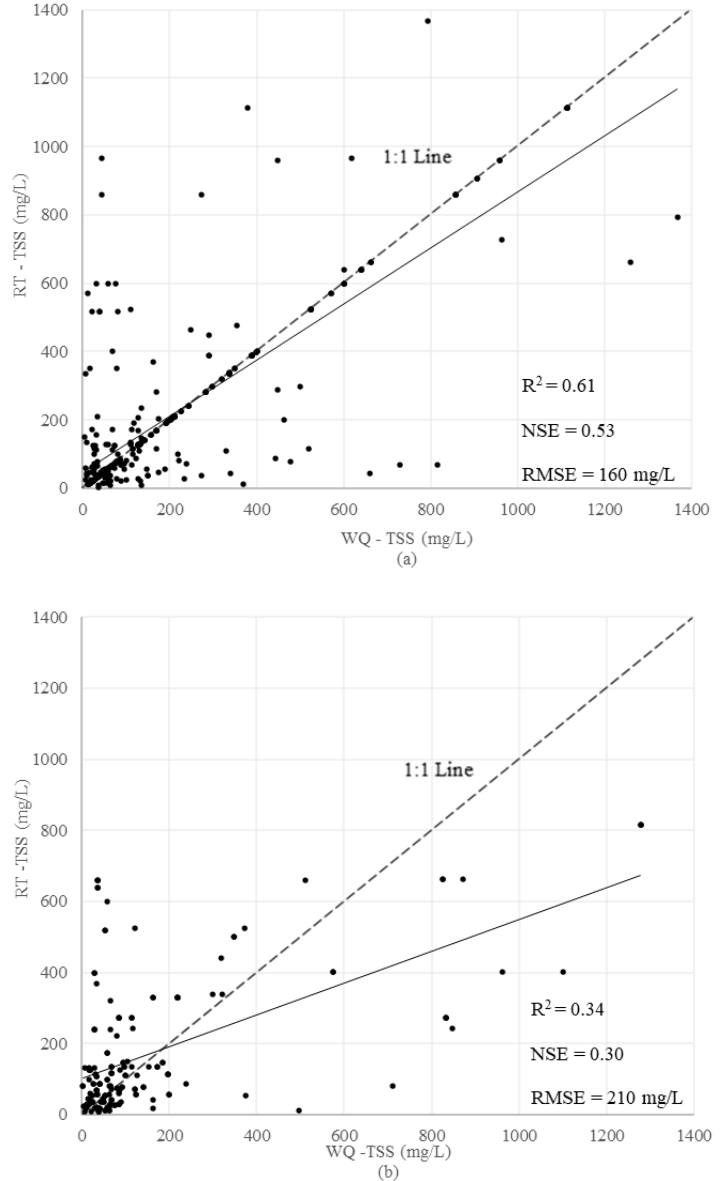
Figure 7. Correlation between the measured values and Regression Tree (RT)-predicted TSS concentration in ( a ) training step and ( b ) prediction step.